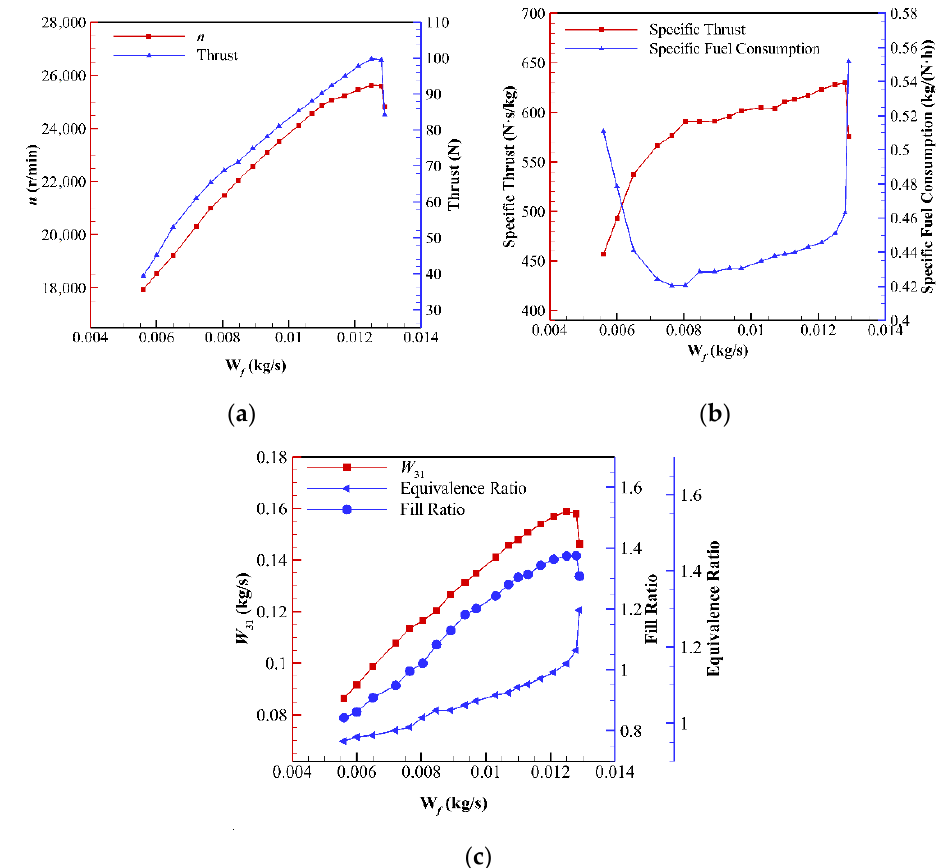
Figure 5. Operating characteristics of PDTE with the increasing of W f . ( a ) Rotor speed and thrust vs W f . ( b ) Specific thrust and specific fuel consumption vs. W f . ( c ) Mass flow rate, equivalence ratio, and fill ratio vs. W f .